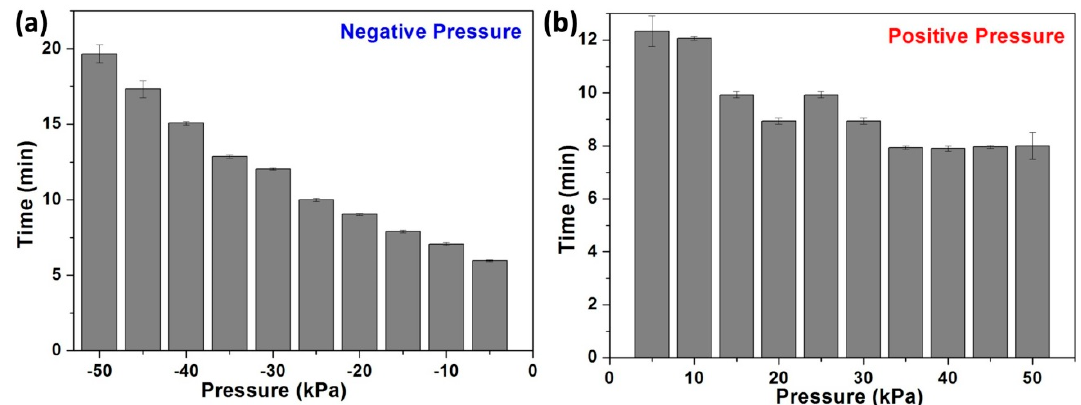
Figure 6. Evaluation of response time in two different pressure atmospheres—negative ( a ) and